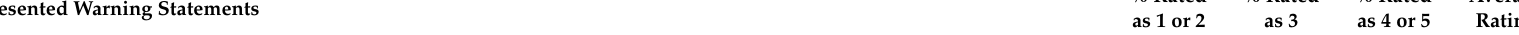
Table 1. Current e-cigarette users’ and non-e-cigarette users’ ratings of proposed e-cigarette warning statements on a scale of 1–5 (1 = not at all effective, 5 = very effective). Presented Warning Statements